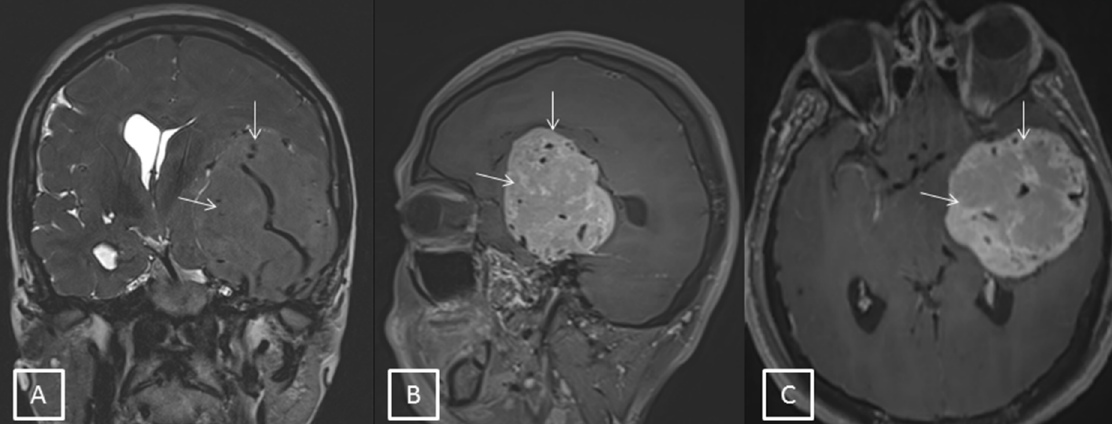
Figure 2: A) Coronal T2-weighted MRI brain showing an iso-hyperintense large mass lesion in the tempo-parietal lobe (white arrows). B,C): Post contrast sagittal and axial cuts showing an intense heterogeneous enhancement of the lesion (white